Question: Which visualization type does this figure use?
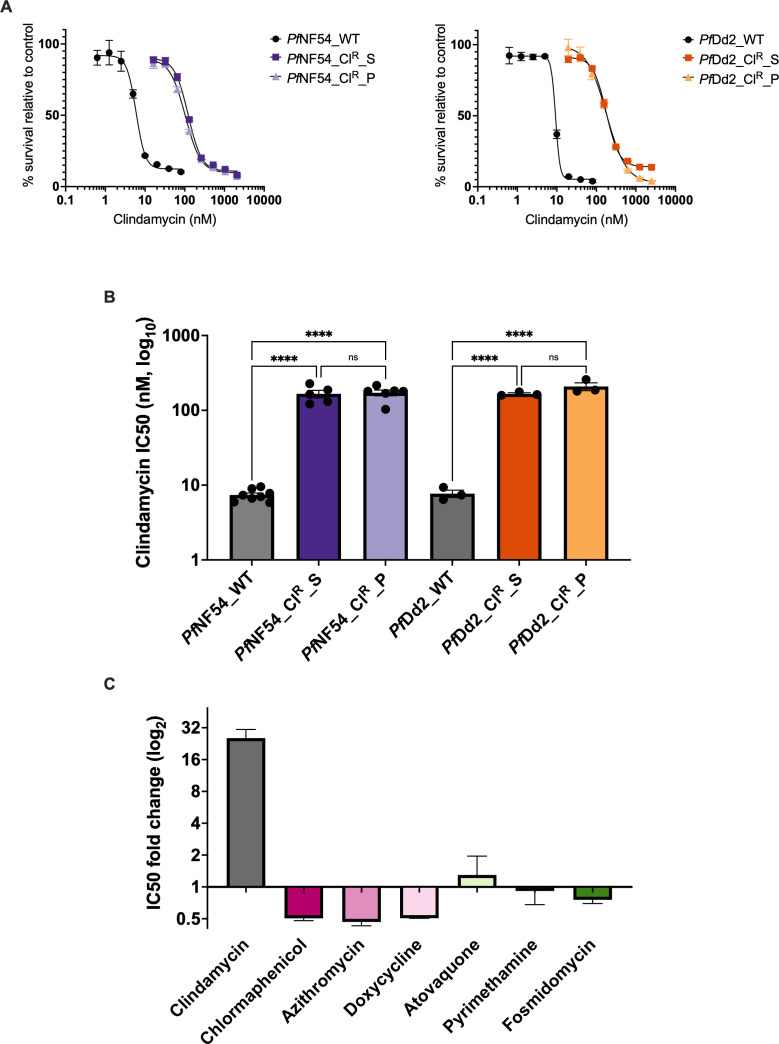
Answer: bar